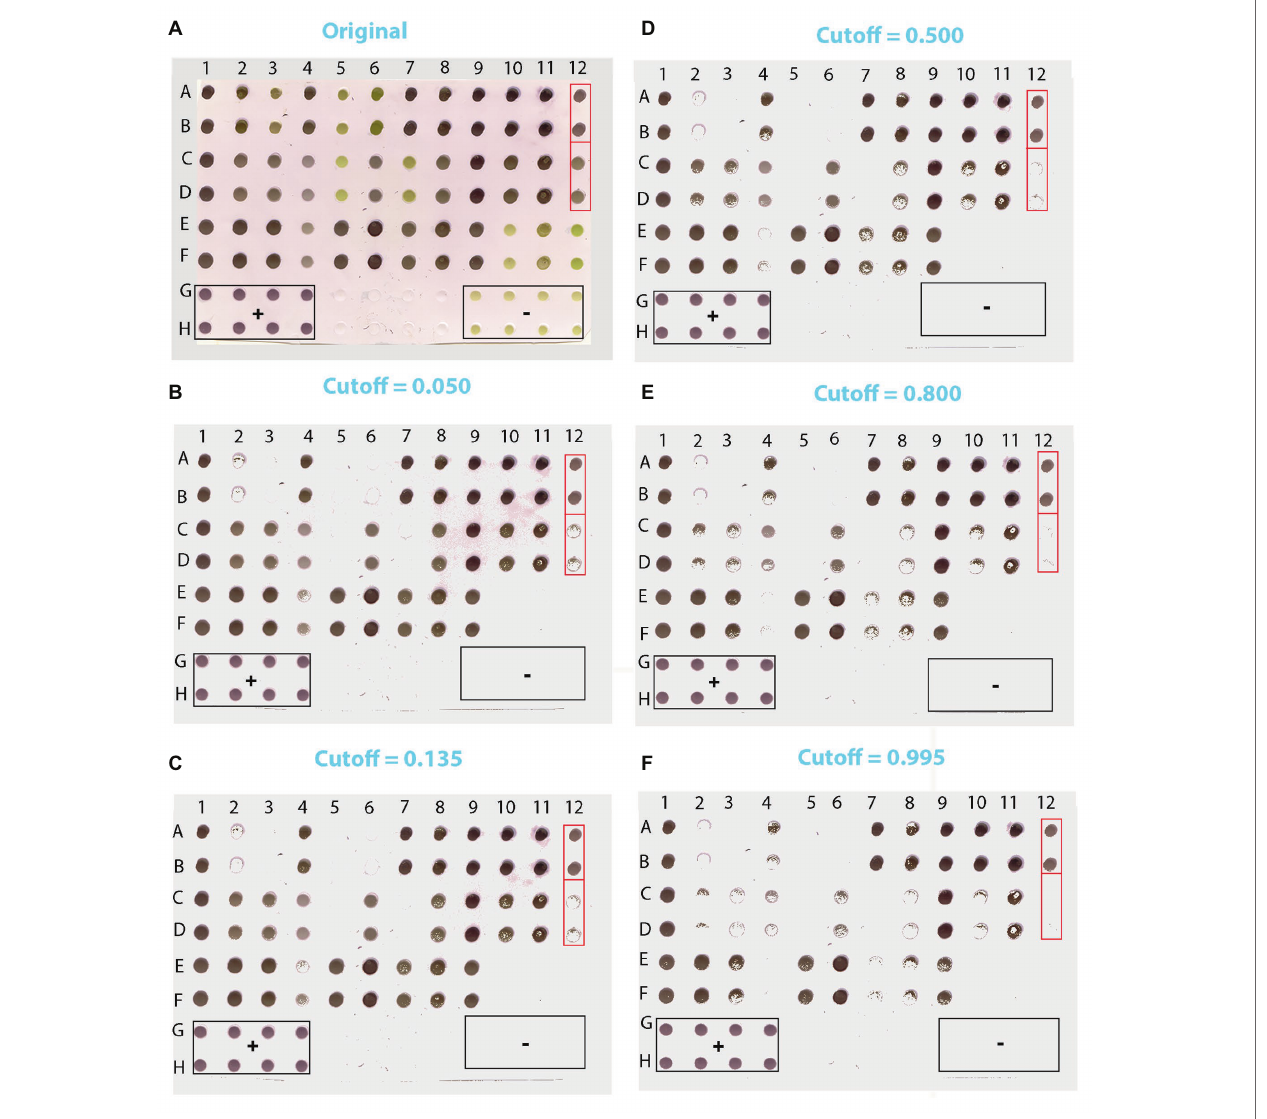
FIGURE 8 | Scanned image of a DE output of lettuce samples suspected for LBVaV infection (A) and the corresponding images reconstituted from pixels applying cutoffs of 0.050 (B) , 0.135 (C) , 0.500 (D) , 0.800 (E), and 0.995 (F) . Duplicates of 36 samples of unknown infection status were loaded in [ (A-F) :(1–12)]. Lanes G and H contain duplicates of positive (+) controls (1–4), Buffer only (5–8), and negative ( − ) controls (9–12). Framed in red are two of the sets of dots of ambiguous diagnosis that appear similar in the original DE output (A) . In the reconstituted images, however, where pixel information of dots has been harnessed, it becomes clear that dots A12:B12 are positive and C12:D12